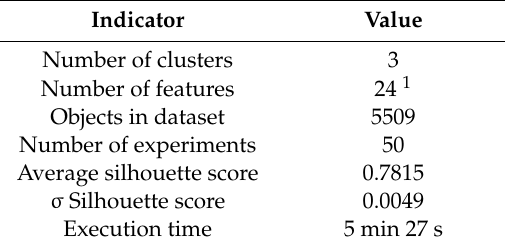
Table 4. Result summary of the k-means clustering algorithm.